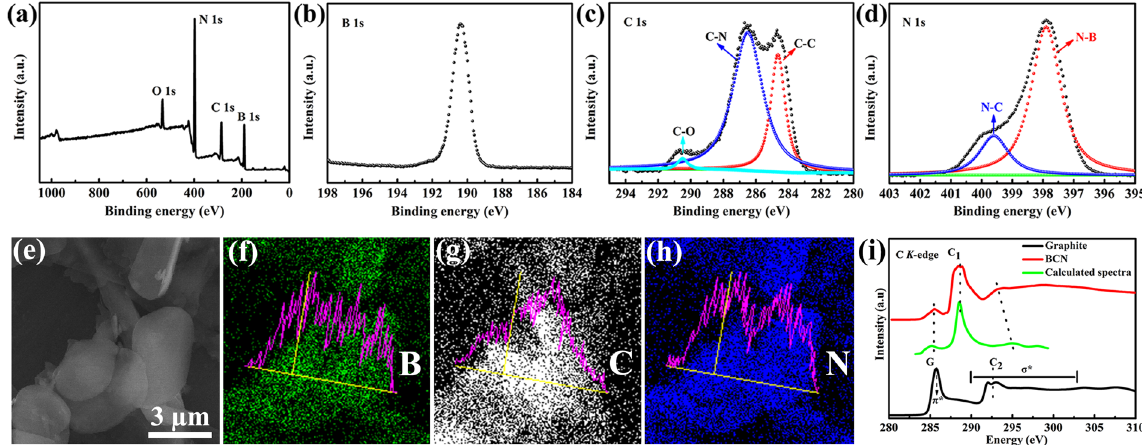
Figure 2. X-ray photoelectron spectroscopy (XPS) spectra and energy dispersive X-ray spectrum (EDS) element mapping of the as-prepared BCN nanosheets. ( a ) XPS survey spectrum of the as-prepared BCN nanosheets and high-resolution XPS spectra of ( b ) B1s, ( c ) C1s, and ( d ) N1s electrons. ( e – h ) SEM image and corresponding EDS element mapping of B, C, and N. ( i ) A comparison of C K -edge X-ray absorption near-edge structure (XANES) spectrum of BCN nanosheets and